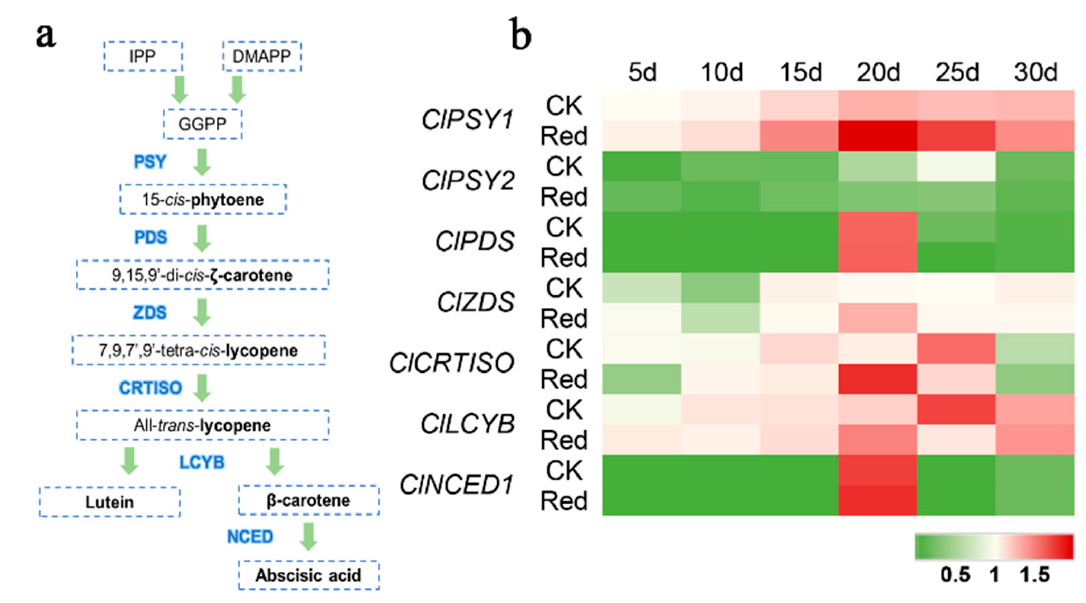
Figure 2. Relative expressions of carotenoid metabolism genes after supplementary red lighting. ( a ) Carotenoid metabolism pathway. ( b ) Changes in carotenoid metabolism genes expression level in watermelons after supplementary red lighting. Phytoene synthase 1 ( ClPSY1 ); phytoene synthase 2 ( ClPSY2 ); phytoene desaturase ( ClPDS ); zeta-carotene desaturase ( ClZDS ); carotenoid isomerase ( ClCRTISO ); lycopene β -cyclase ( ClLCYB ); 9- cis -epoxycarotenoid dioxygenase1 ( ClNCED1 ). Red: supplementary red lighting; CK: natural light (control). The data show mean values of three repli- cates (±SD) with three plants per replicate. Green indicates a decrease and red an increase in gene expression (see the color set scale in the lower-right corner).